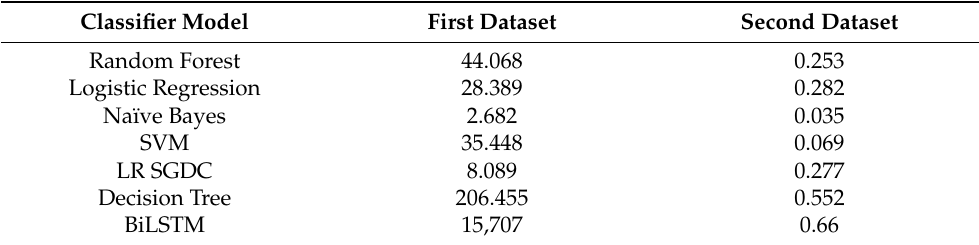
Table 12. Time complexity of different models for each dataset